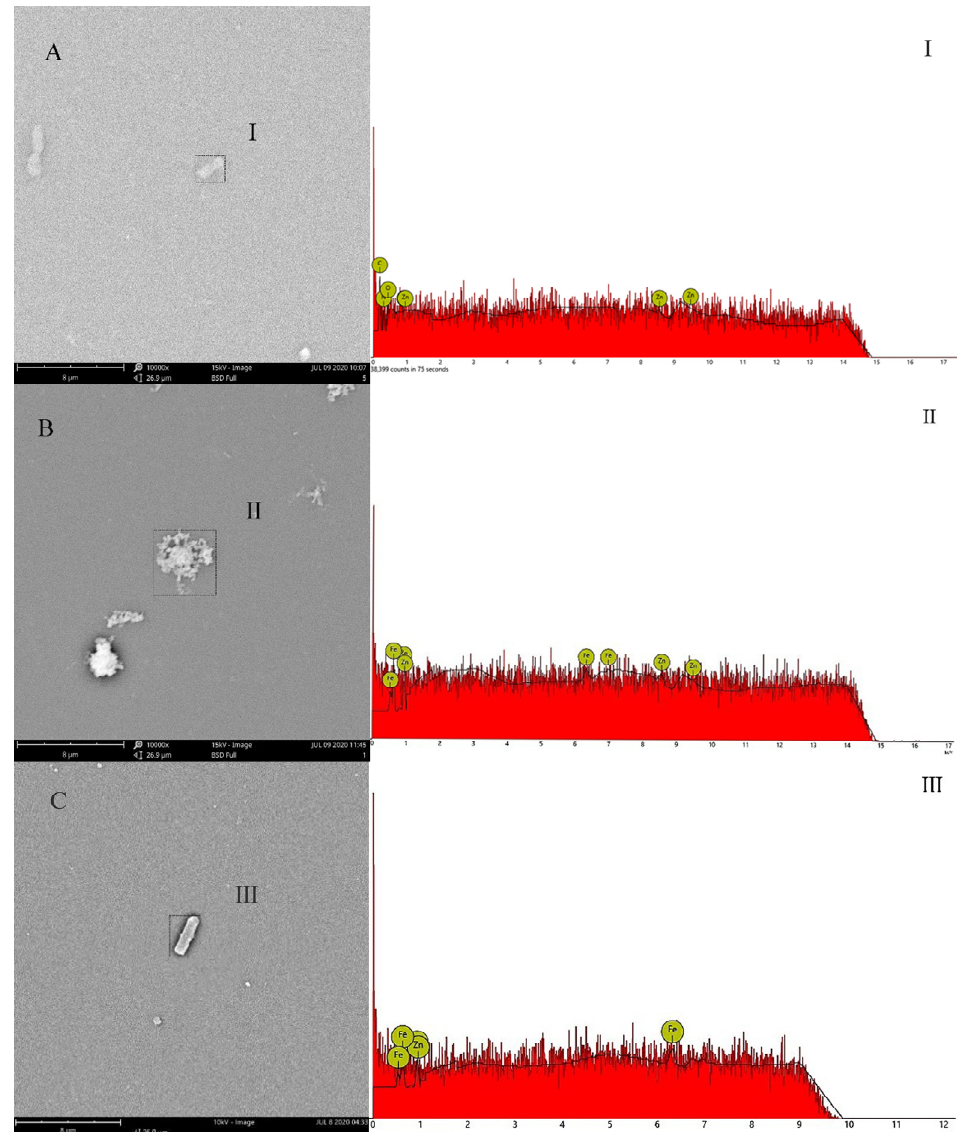
Figure 5. SEM-EDS images of Y-11 exposed to 5 mg/L ZnO-NPs with or without Fe 2+ . ( A ) is Fe 2+ -free treatment; ( B ) is Fe 2+ adsorbed on ZnO-NPs; ( C ) is Fe 2+ -containing treatment.